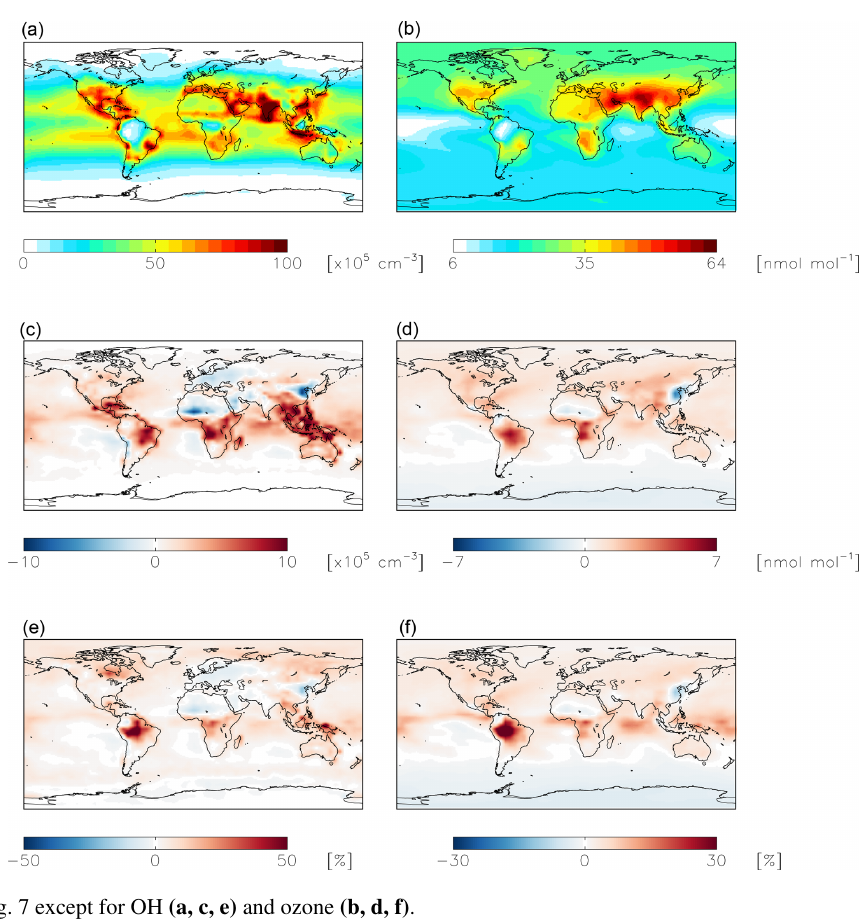
Figure 8. Same as Fig. 7 except for OH (a, c, e) and ozone (b, d, f) .